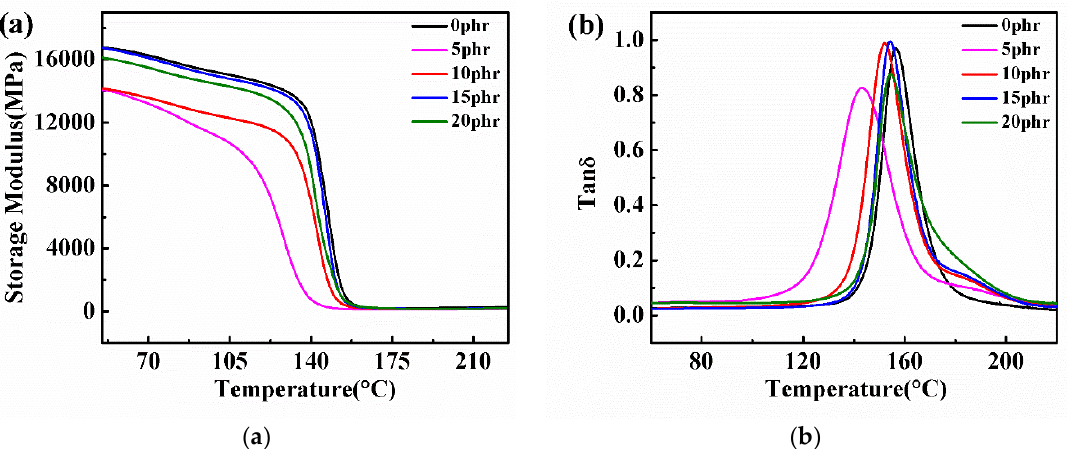
Figure 5. Curves of ( a ) storage modulus E’ and ( b ) tan δ with temperatures of PSF/epoxy cured products containing different PSF content.